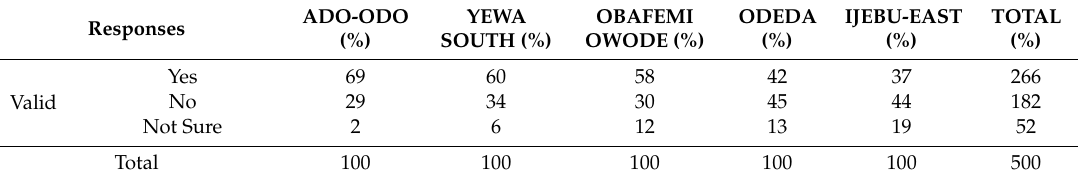
Table 11. Responses on the relevance of education and awareness to good SWM